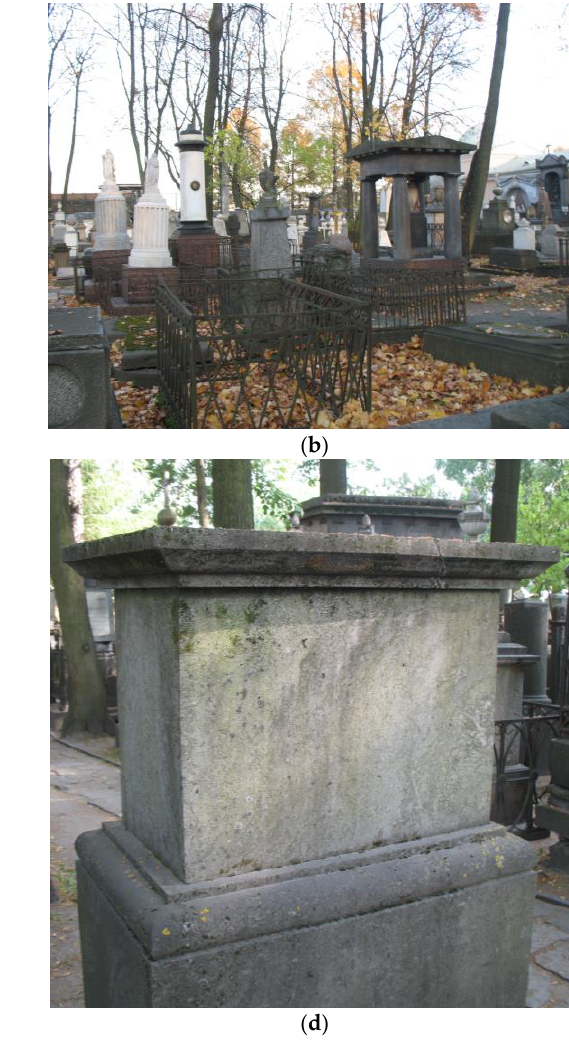
Figure 1. Sampling sites: Ruskeala quarry ( a ); Alexander Nevskay Lavra ( b ); Biolayers on marble in the Ruskeala quarry